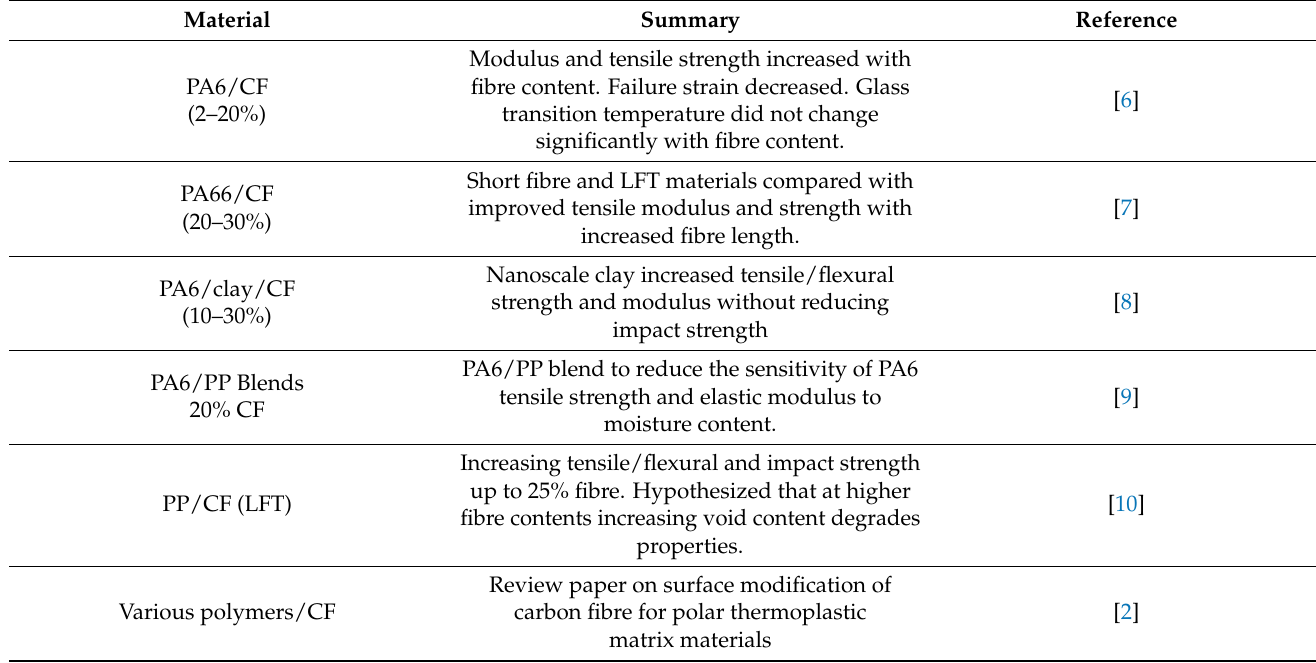
Table 1. Carbon-reinforced thermoplastic literature review.